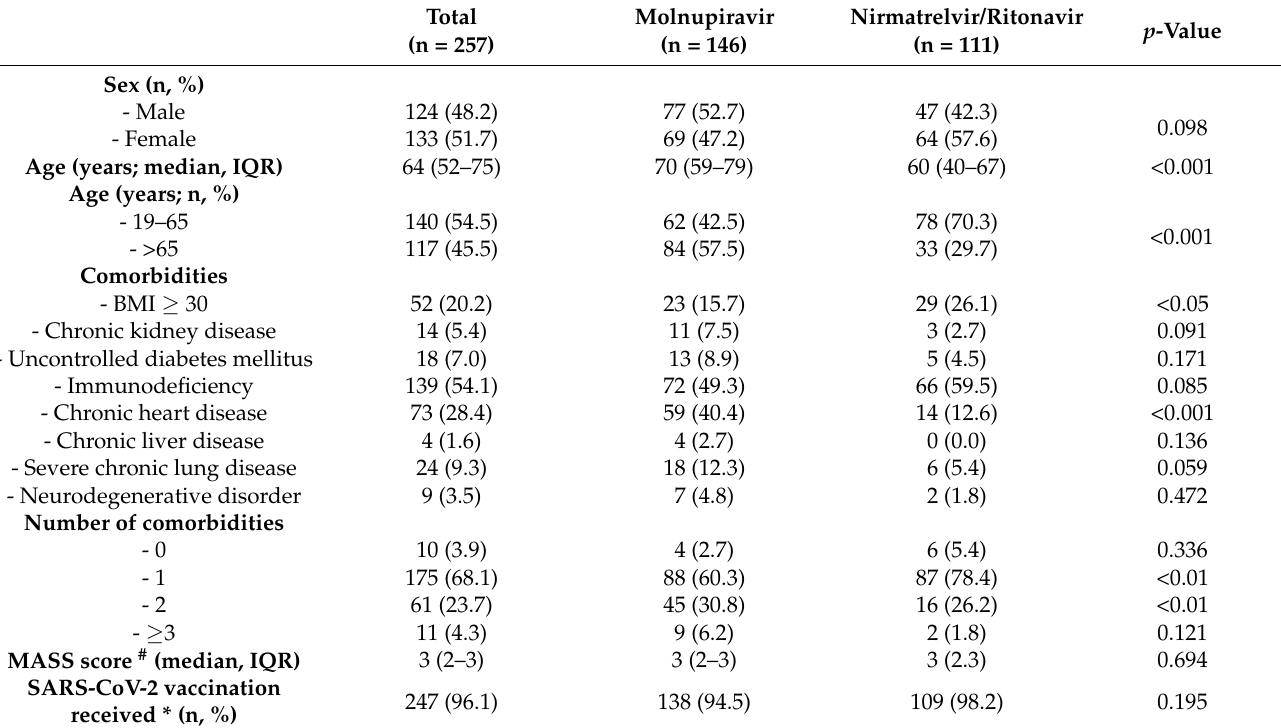
Table 1. Clinical characteristics of patients with SARS-CoV-2 infection who received oral antiviral therapy.